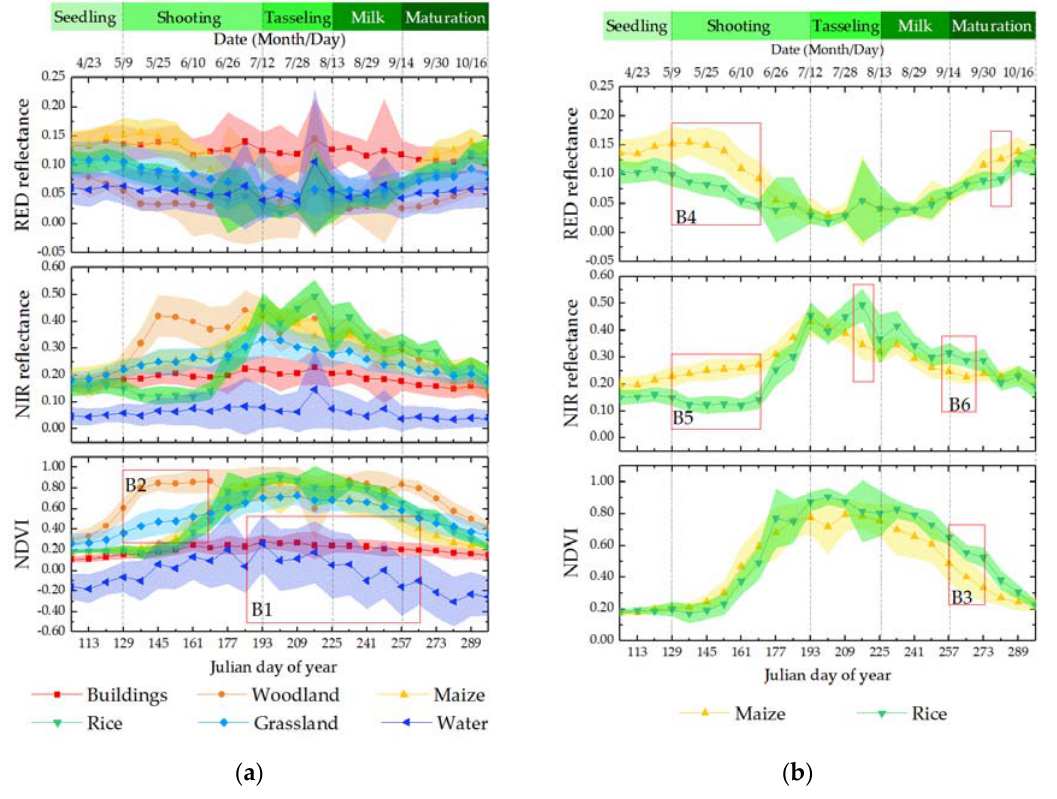
Figure 5. Averaged NDVI, red reflectance and near-infrared reflectance time-series curves for different land cover types ( a ) and major crops ( b ). The shadows represent the range of mean ± 1 times of the standard error.